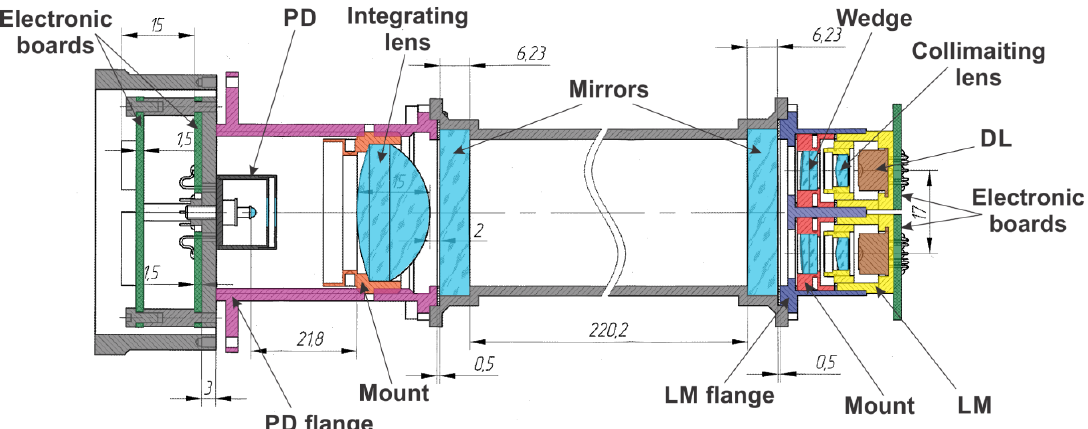
Figure 4. The sectional drawing of the ICOS cell, implemented in the M-DLS. Light blue parts show all optical components, including two collimating lenses, two optical wedges, two mirrors and the integrating lens. DLs (diode lasers) are brown, green elements are electronic boards, LM (laser module) constructions are yellow, optical wedge mounts are red and the LM flange is navy-blue. From the left cell side: PD (photodiode) is black, the integrating lens mount is orange and the PD flange is magenta. The ICOS cavity body and PD set are gray. (For interpretation of the references to color in this figure, the reader is referred to the web version of this article).